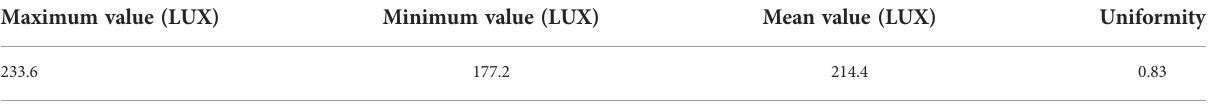
TABLE 2 The illumination distribution analysis with a lighting distance of 6m.